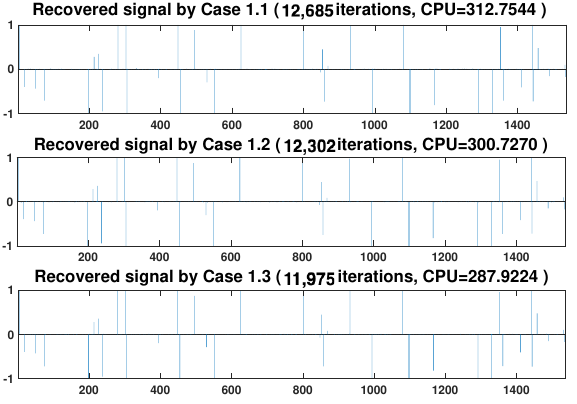
Figure 12 which are composed of the recovered signal.